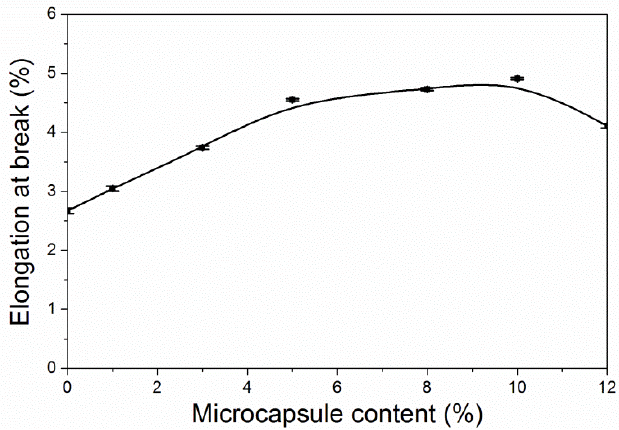
Figure 6. Effect of amounts of microcapsules added on elongation at break of coating.